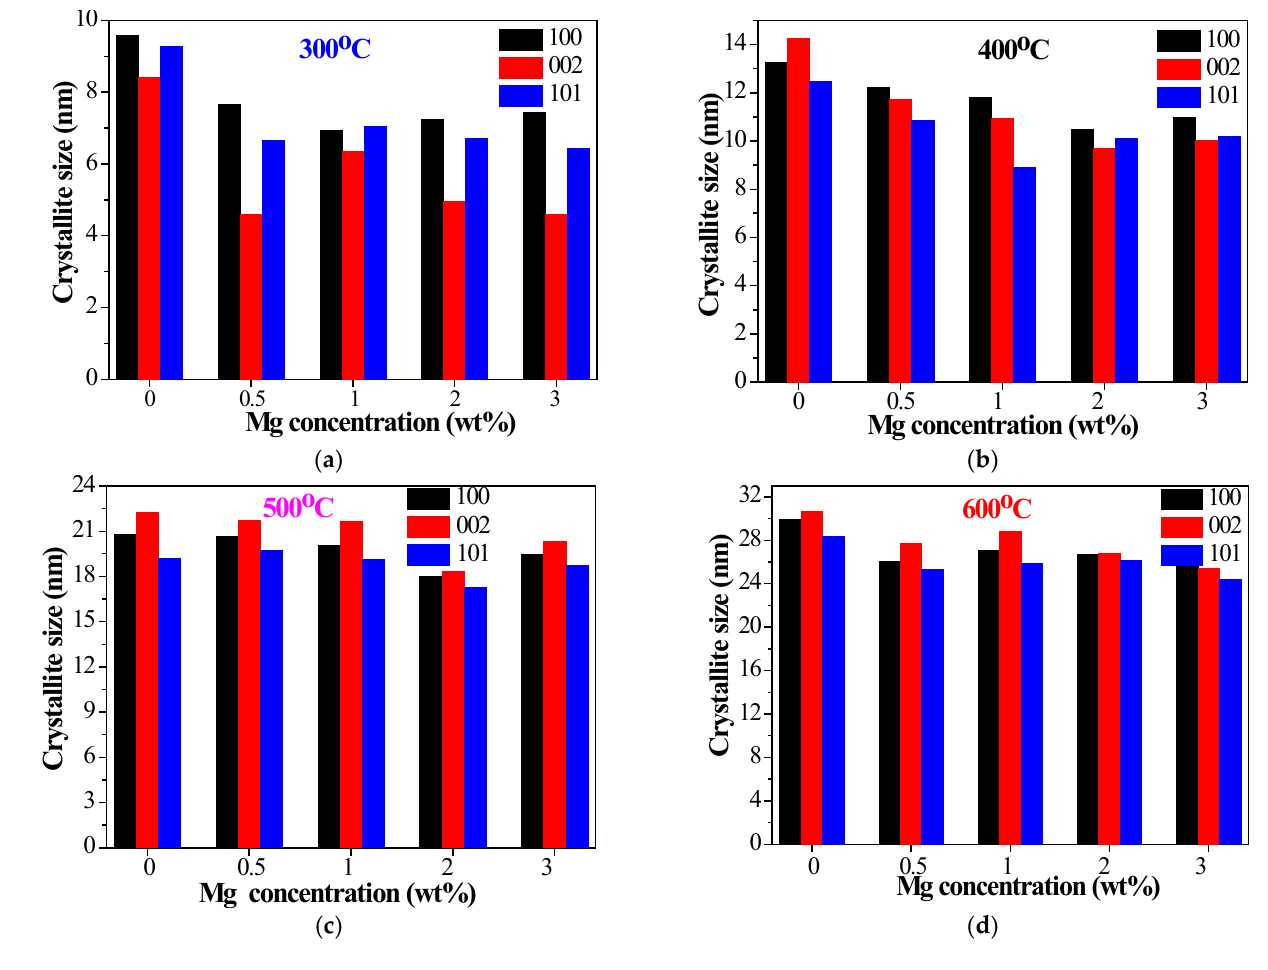
where I ( hkl ) and I o ( hkl ) are the measured relative intensity and JCPDS standard intensity, respectively, of a plane ( hkl ); N is the reflection number; and n is the number of diffraction peaks. If there is a preferential orientation, the TC (hkl) value should be greater than one. If TC ( hkl ) is equal to or less than 1, then the sample is proposed to have randomly oriented crystallites. The texture coefficient was determined for the sol–gel ZnO and Mg-doped ZnO films using Equation (2). TC values were calculated for the diffraction planes (100), (002) and (101) considering the measured and standard (JCPDS card 01-070-8070) intensities of all detected peaks. The degree of the preferred orientation for three diffraction planes is given in Figure 5. ZnO-based films demonstrate a preferential growth along the (002) plane as the TC values of ZnO and ZnO:Mg films are greater than 1 (see Figure 5a). For example, TC (002) values of ZnO films are increased up to 2.46 with increasing annealing temperatures, along with a decrease of the TC (100) and TC (101) values. On the other hand, ZnO:Mg films also reveal the highest values for TC (002) in comparison to those